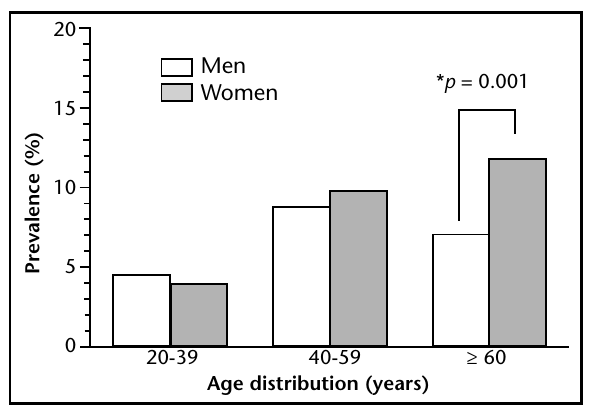
Figure 1 – Prevalence of laboratory profile of the metabolic syndrome in men and women according to age distribution * p -value for the comparison between men and women in each age range (chi-square test).